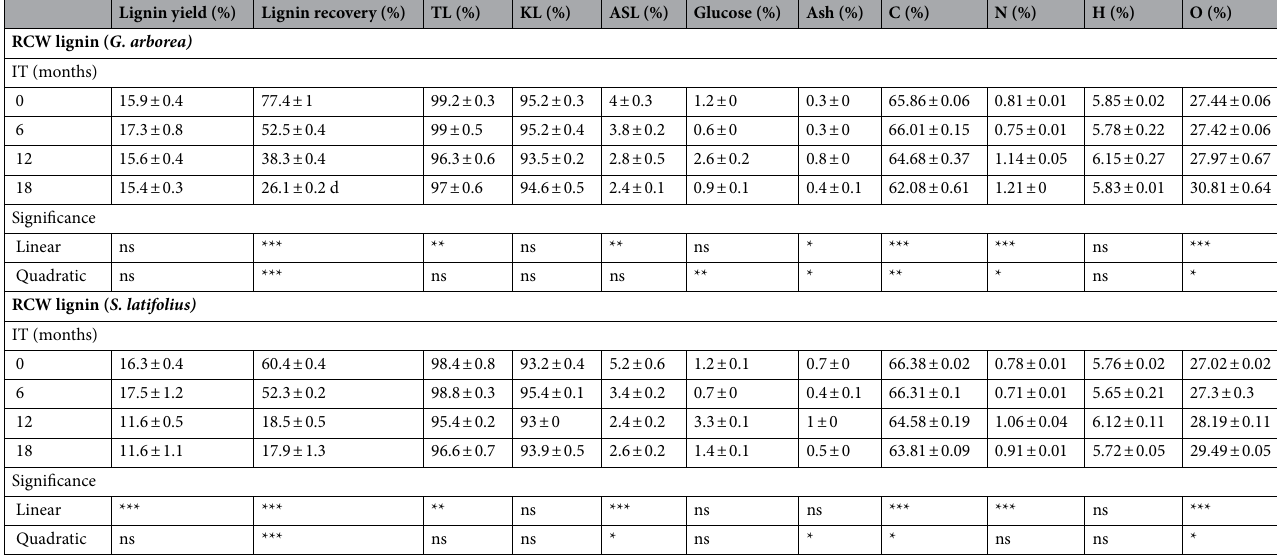
Table 3. Properties and elemental analysis of lignins isolated from G. arborea and S. latifolius RCW at 0, 6, 12 and 18 months of decomposition in soils. Results are expressed as means ± standard errors in triplicate; IT, RCW Incubation times (months) in soil; TL, total lignin; KL, Klason lignin; ASL, acid soluble lignin; *Contrasts significant at the 0.05 level, **Contrasts significant at the 0.01 level, ***Contrasts signifi cant at the 0.001 level, ns = not